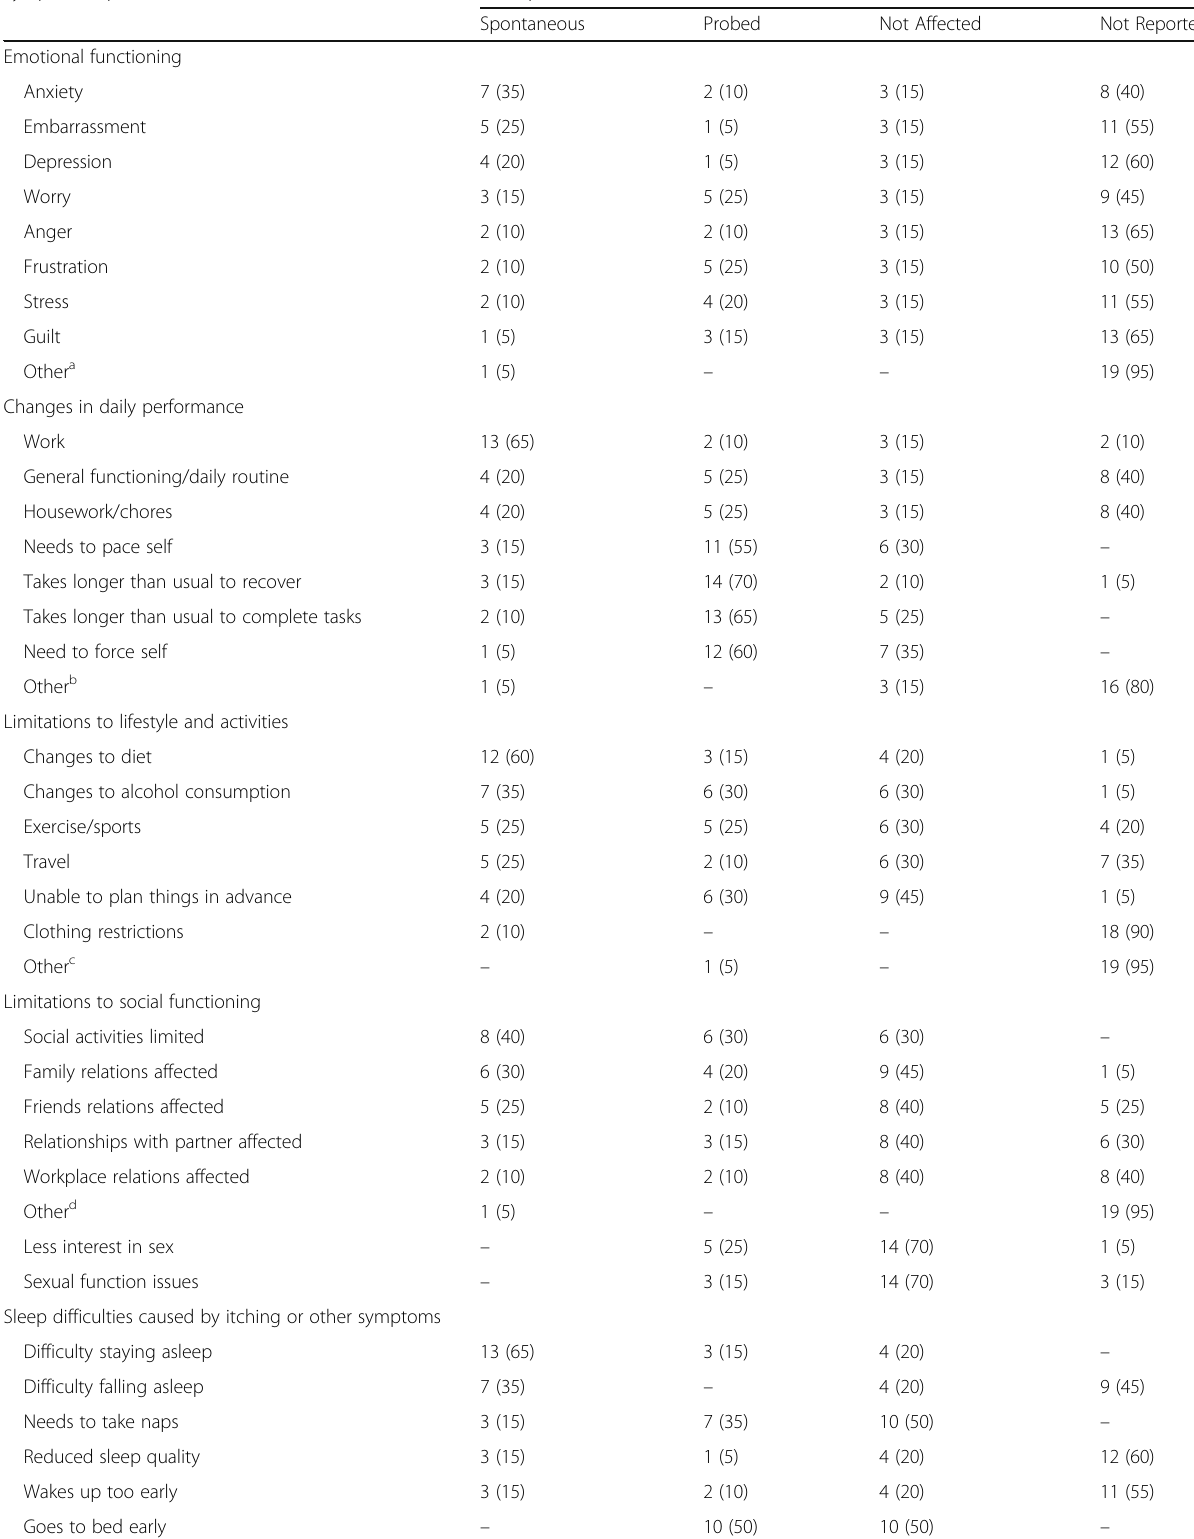
Table 5 Spontaneous vs probed impact expressions during the CE portion of the interviews Symptom Reported, n (%) Participants, N = 20 Spontaneous Probed Not Affected Not Reported Emotional